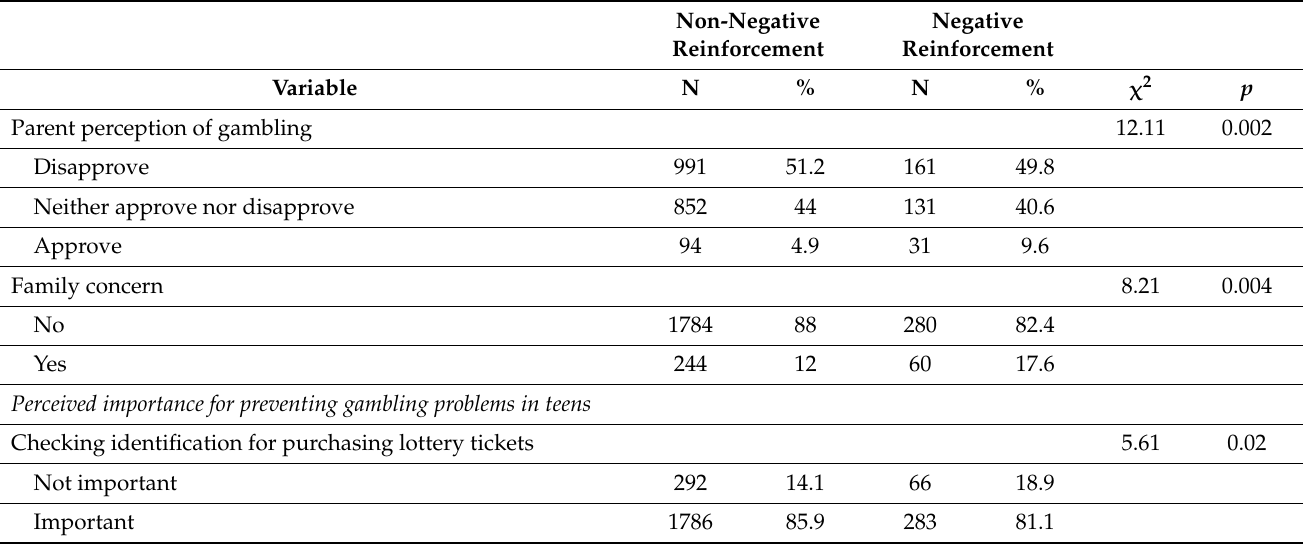
Table 3. Gambling perceptions stratified by negative-reinforcement-shopping